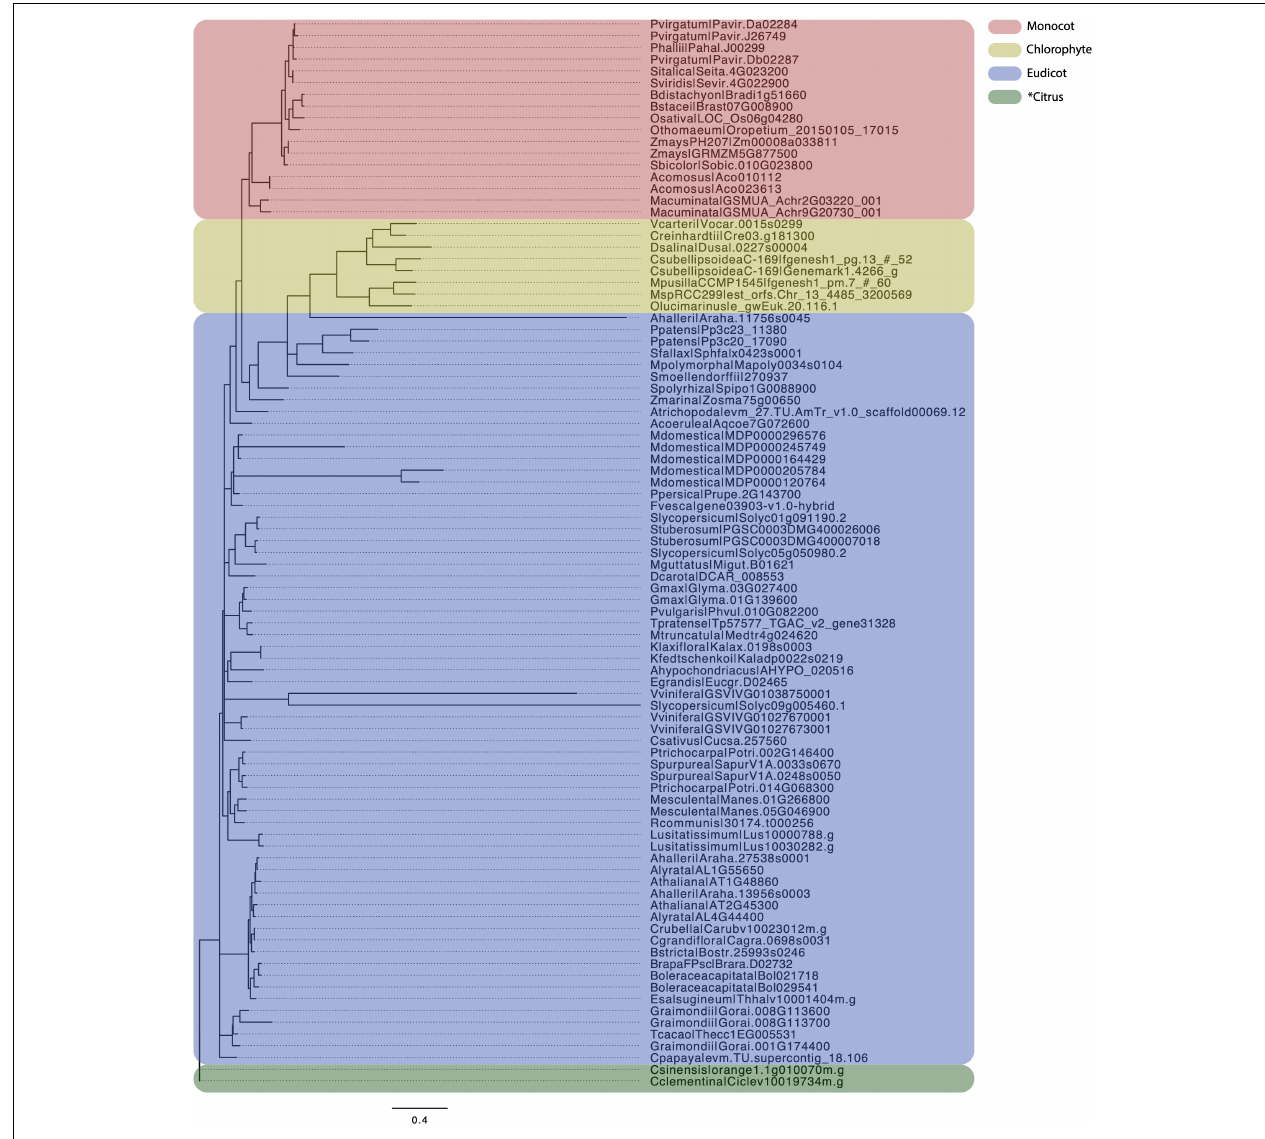
FIGURE 3 | Molecular dating of EPSPs. A total of 91 EPSPs, identified by searching against PtrEPSP-TF in phytozome, were used for molecular dating analysis. We first used MUSCLE (Edgar, 2004) to perform multiple alignments of EPSP proteins, an in-house python script was then used to convert the amino acid alignment to nucleotide alignment, and finally TrimAL (Capella-Gutiérrez et al., 2009) was used to trim the alignment using parameters “-gt 0.8 -st 0.001,” which indicate the tolerating gaps of no more than 20% and similarity score less than 0.001. Mrbayes (Huelsenbeck and Ronquist, 2001) was used to conduct molecular dating with parameters “lset nst = 6 rates = invgamma” using the “GTR + I + (cid:48) ” model. A total of 10,000,000 mcmc generations were run after the standard deviation of split frequencies falls under 0.05. FigTree (Rambaut, 2012) was used to visualize the phylogenetic tree. Number of each node indicates the posterior probabilities. Pink, yellow, blue, and green colors separate monocot, Chlorophyte, Eudicot, and Citrus,